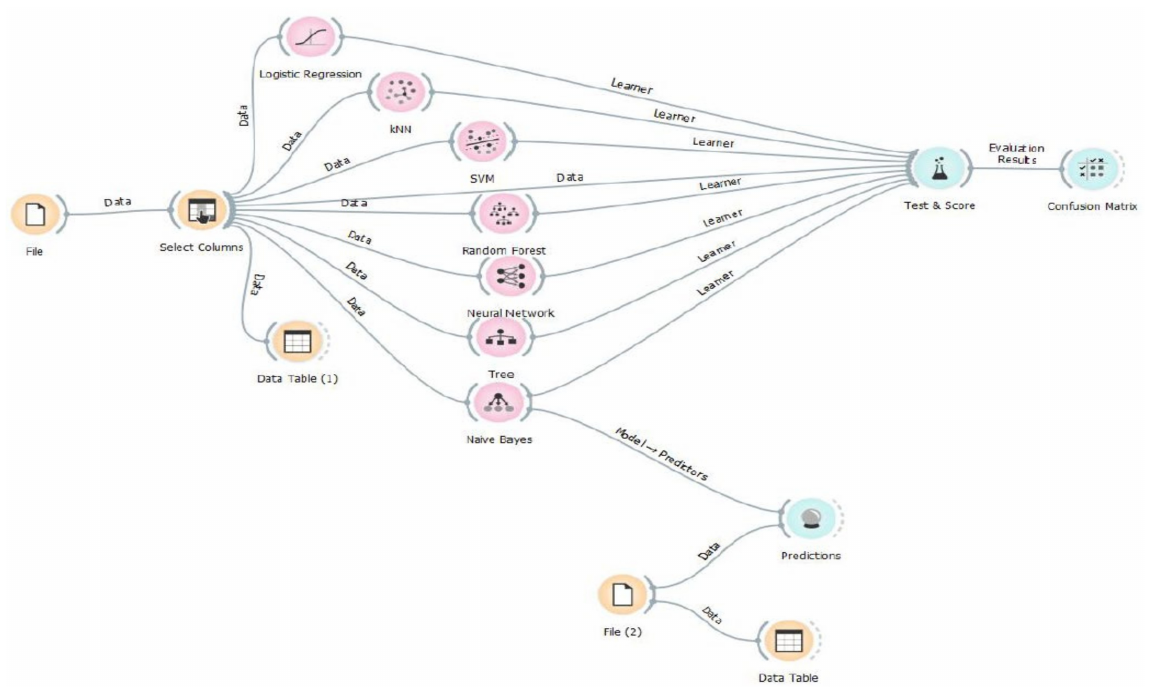
Figure 13. Simulation model in Orange software environment showing seven different machine learning methods of data processing from the input File with the data from which the neural network will learn from. File (2) goes to the widget and uploads the data, where human error caused unclassified